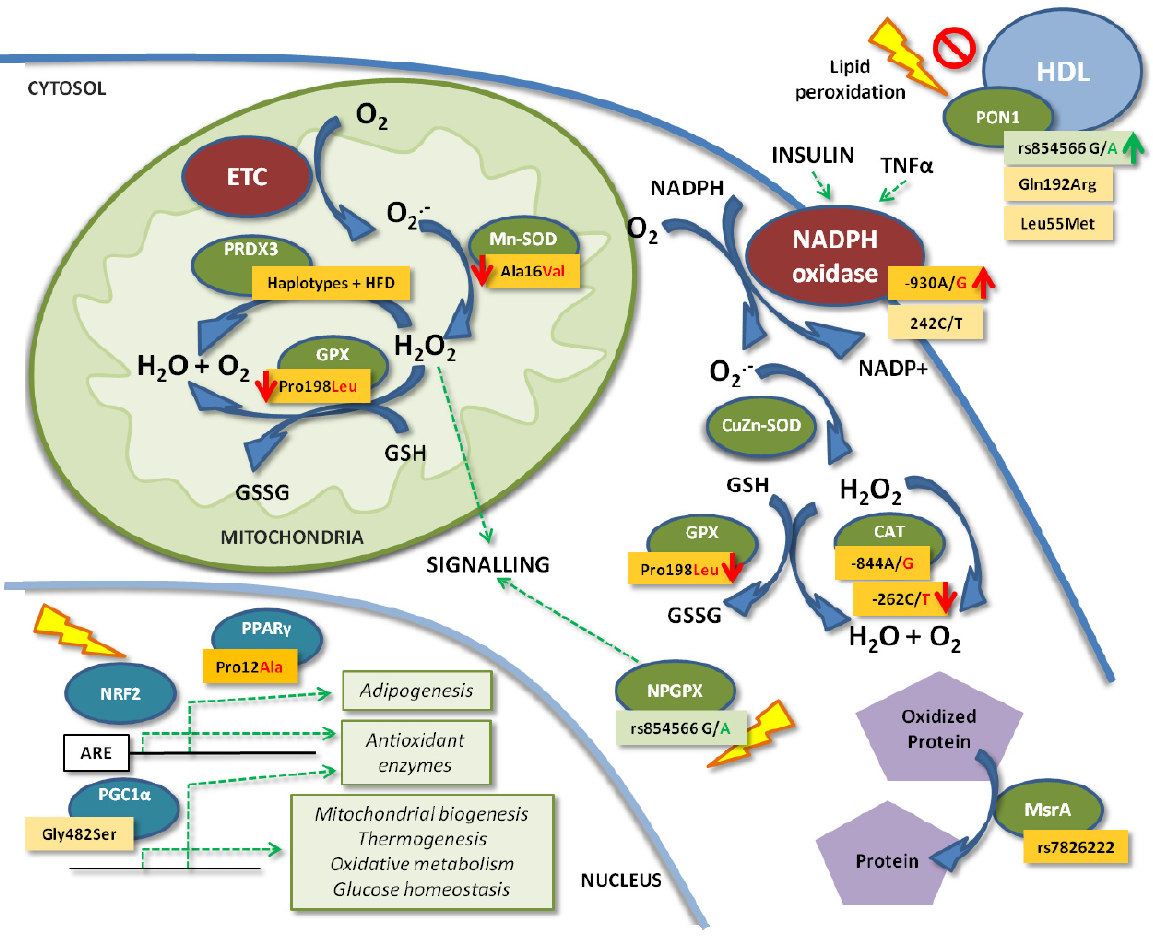
Figure 2. Effects of the main known SNPs of the antioxidant defense system genes in the cell on obesity. Dark orange and green boxes indicate higher or lower obesity risk associated with the SNP, respectively. Light orange boxes indicate conflicting results. Red and green arrows matching the color of an allele of the SNP indicate higher or lower enzyme activity associated with that allele. Dashed green arrows indicate activation. CAT, catalase; CuZn-SOD, copper-zinc superoxide dismutase; ETC, electron transport chain; GPX, glutathione peroxidase; GSH, reduced glutathione; GSSG, oxidized glutathione; HDL, high-density lipoprotein; HFD, high-fat diet; Mn-SOD, manganese superoxide dismutase; MsrA, methionine sulphoxide reductase A; NADPH, nicotinamide adenine dinucleotide phosphate; NPGPX, non-selenocysteine-containing phospholipid hydroperoxide glutathione peroxidases; NRF2, nuclear erythroid factor 2-like 2; O 2• − , superoxide; PGC1 α , peroxisome proliferator-activated receptor γ coactivator-1 α ; PON1, paraoxonase 1; PPAR γ , peroxisome proliferator activated receptor gamma; PRDX3, peroxiredoxin 3; TNF α , tumor necrosis factor